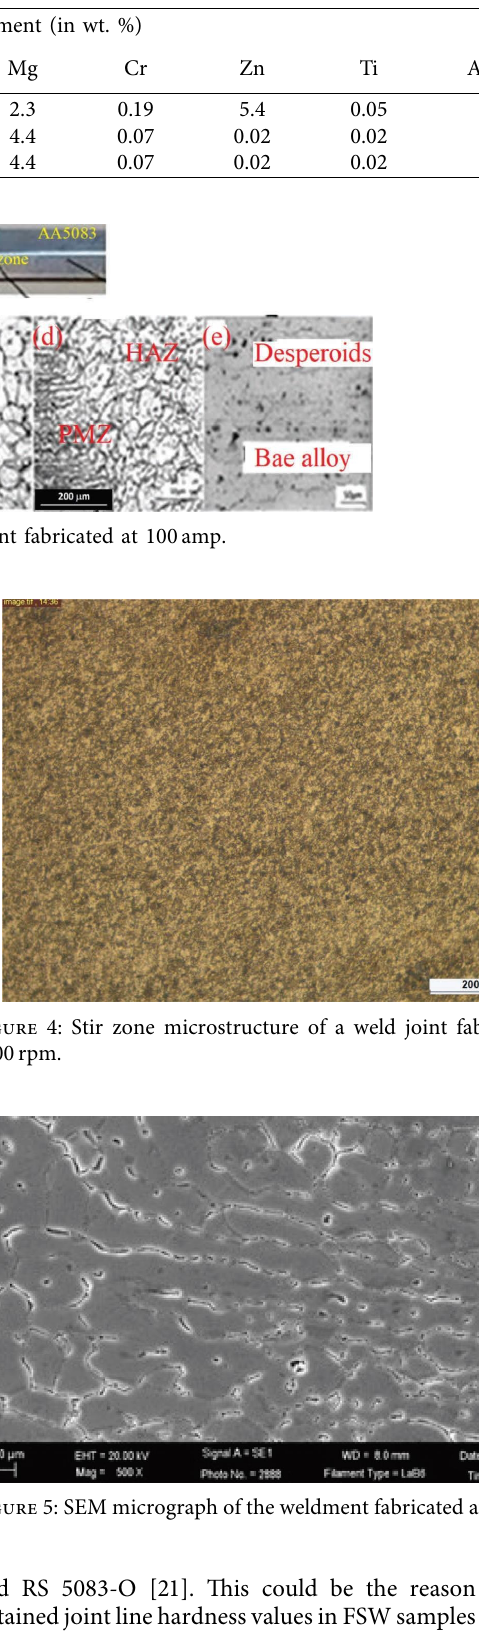
Table 1: Chemical composition of base alloys and electrode used in TIG.